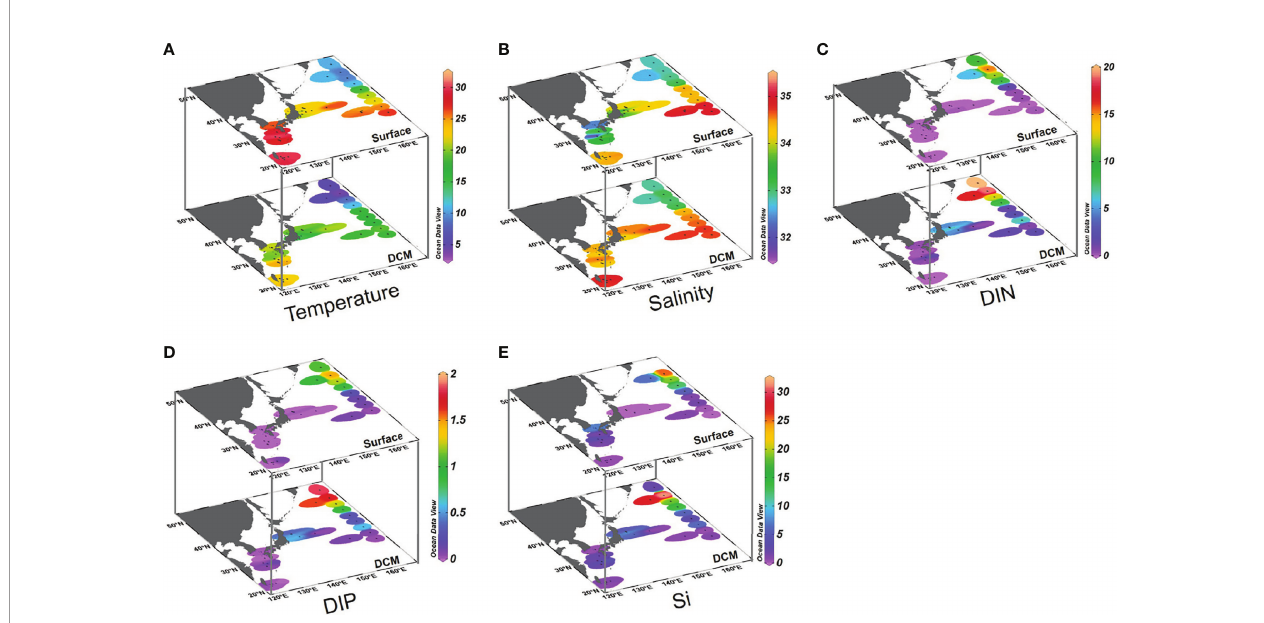
FIGURE 2 | Distributions of temperature, salinity and nutrients in Northwest Paci fi c Ocean surface and DCM waters during summer: (A) temperature (°C), (B) salinity (PSU), (C) dissolved inorganic nitrogen (DIN; m mol L − 1 ), (D) dissolved inorganic phosphorus (DIP; m mol L − 1 ), and (E) dissolved silicate (Si; m mol L − 1 ). Note the difference in color